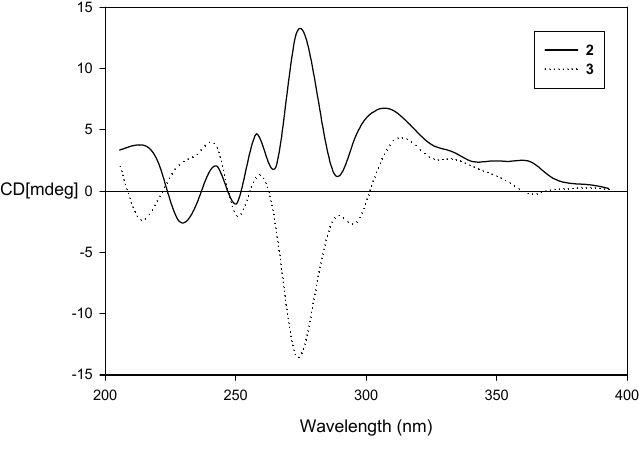
Figure 4. CD data of compounds 2 and 3